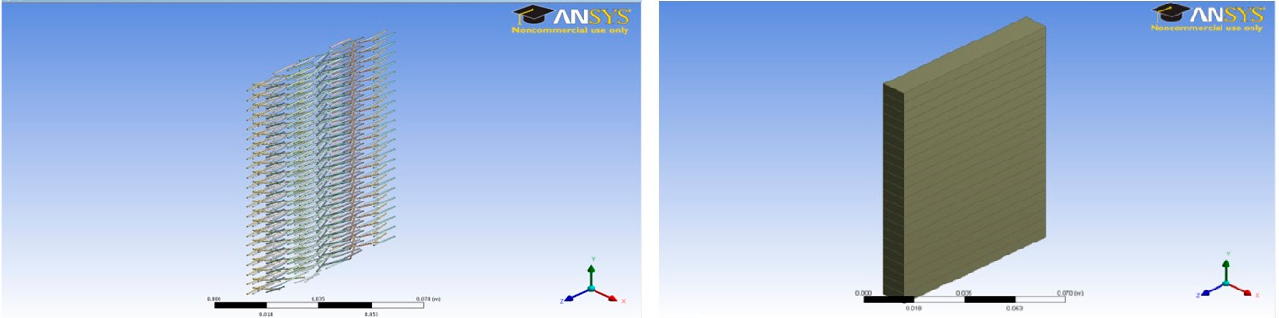
Figure 6. Three percent fiber sample model (11 × 7 × 1 cm) and concrete slab.